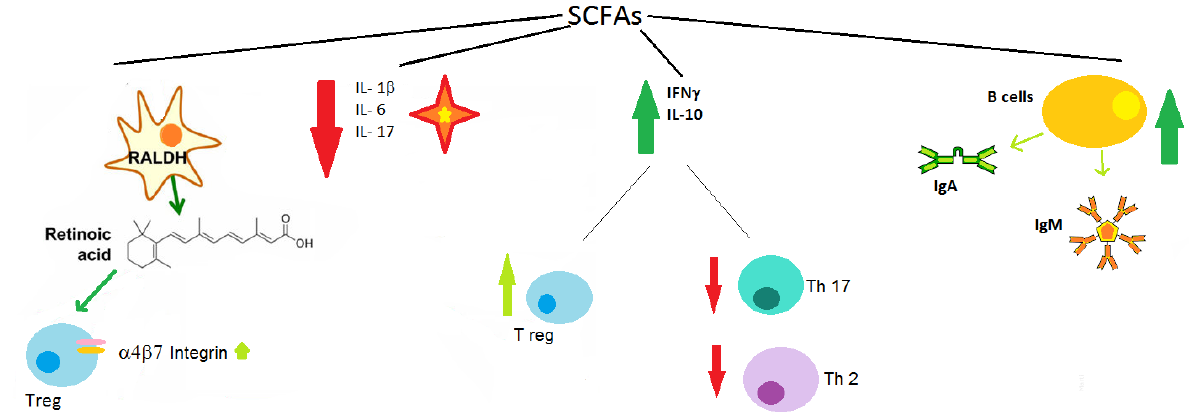
Figure 3. SCFAs effects in immunological tolerance: induce gut dendritic cells (DC) to express retinal aldehyde dehydrogenase (RALDH), with result in the production of retinoic acid that upregulates expression of the gut-homing integrins α 4 β 7 on peripheral regulatory T cells (Treg); promote immune tolerance, regulate the antibody response through the production of IgA and IgM; stimulate the production of anti-inflammatory mediators such as IFN γ and IL-10, which induce the expansion of Treg cells and the suppression of proinflammatory T helper 17 (Th17) and Th2 cells; reduce the production of proinflammatory cytokines including IL-1 β , IL-6, and IL-17. In addition to the production of SCFA, intestinal bacteria also produce polyamines (PA) (spermidine, spermine, putrescine, cadaverine) essential for maintaining the intesti- nal barrier function through upregulation of junctional proteins. The rise of food allergy in modern society has led to the postulation of the hygiene hypothesis, according to which lack of early childhood exposure to infectious agents sup- presses the development of the immune system with the rise of atopic diseases. Recent work has revisited the hygiene hypothesis model to include mode of delivery, antibiotic intake, diet, and synthetic chemicals as factors in altering gut microbiota [3]. After the introduction of the complementary diet, the composition of the microbiota varies accord- ing to the diet applied with evident compositional differences between a diet rich in fiber, characterized by Alistipes , Bilophila , and Bacteroides , and higher abundance of Roseburia , Ruminococcus , and Eubacterium , and diet rich in fat. In general, Lactobacillus , Clostridium , Ruminococcus , Peptostreptococcus , and Bacteroides are species that, through the cataboliza- tion of tryptophan, are able to regulate the immune response and the proliferation of T lymphocytes with consequent induction of the expression of the IL-10 receptor-1 (IL-10R1) and inhibition of proinflammatory cytokines [85]. In this context, it is clear that a diet that is higher in fat but low in fiber, like the Western one, maybe the cause of the increased prevalence of FA in Western countries [86]. About that, Mckenzie et al. have described the “ nutrition-gut microbiome-physiol- ogy axis ” , an essential link between diet, gut microbiota, and allergic diseases. It was also shown that food diversity was associated with greater expression of Foxp3, suggesting a protective effect of a diversified diet against the development of FA. On the contrary, re- duced Foxp3 expression was present in children with a less diversified diet [1]. Data supporting the ability of the microbiota to influence allergic sensitization was found in mice treated with antibiotics and GF, which developed greater allergic sensitiza- tion than controls. In particular, Jiménez-Saiz R et al. demonstrated that eosinophil-defi- cient GF mice had intestinal fibrosis and were less prone to allergic sensitization than GF